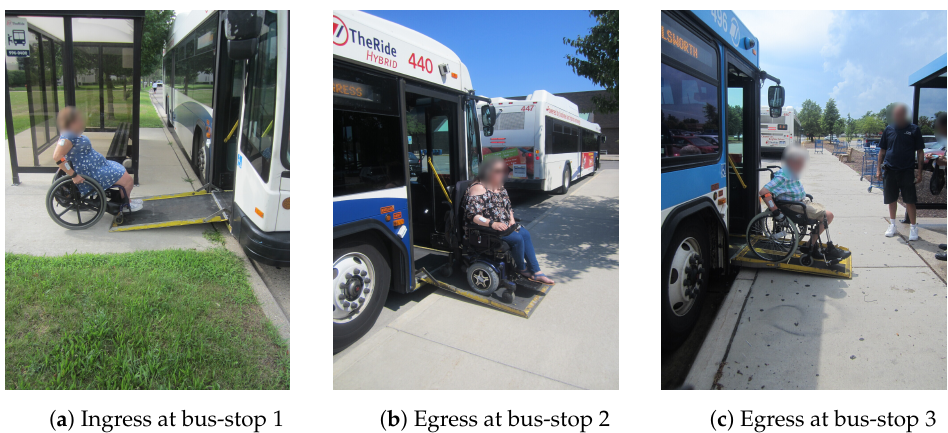
Figure 2. Images depicting a wheeled mobility device user at the three bus stops used in the study ( a ) Stop 1 at the start of Trip-1 and end of Trip-3, ( b ) Stop 2 used between Trips 1 and 2, and ( c ) Stop 3 used between Trips 2 and